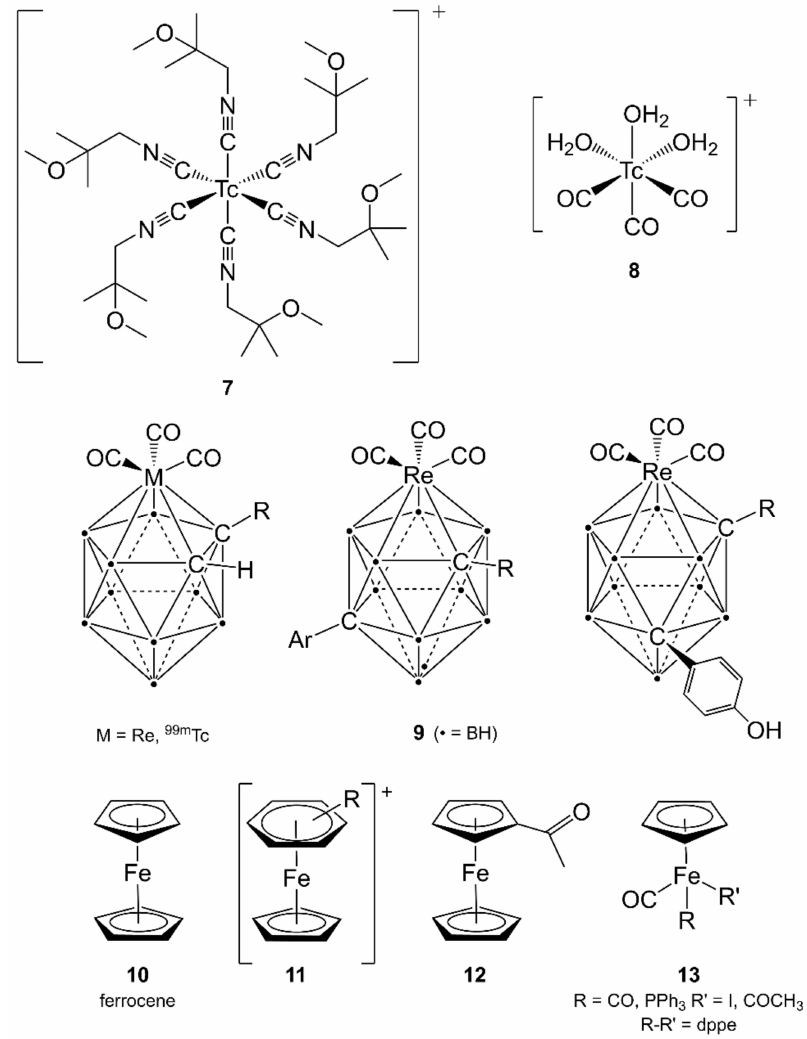
Figure 4. A selection of complexes containing Tc, Re, and Fe cited in the